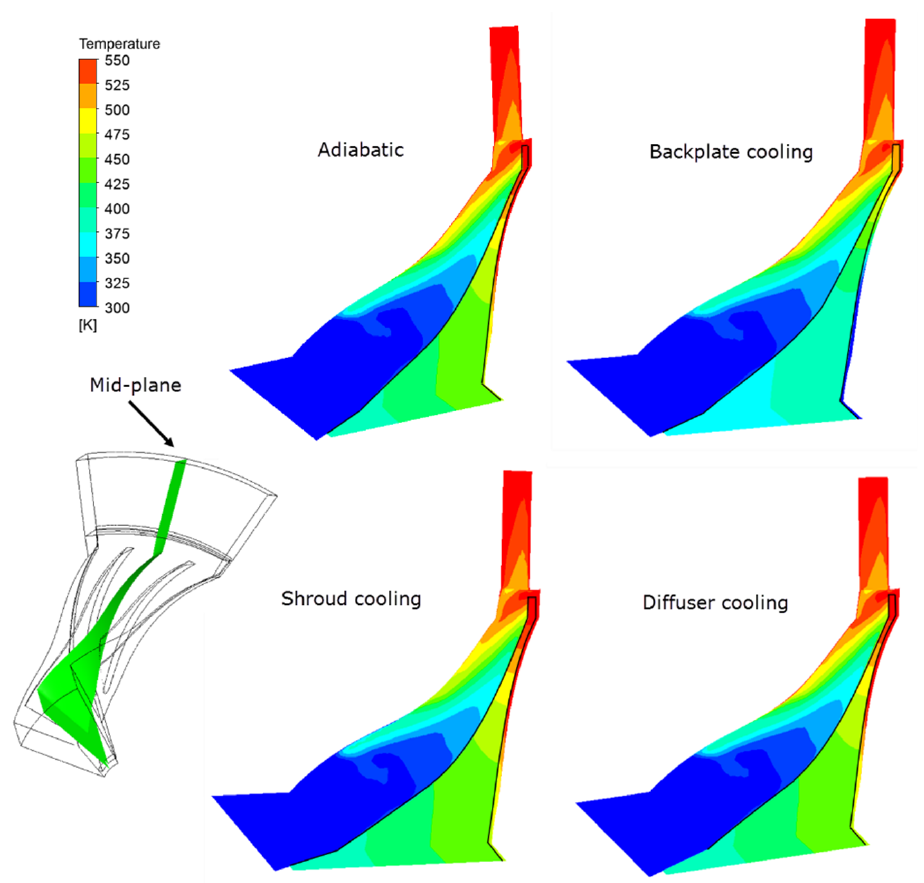
Figure 7. Enthalpy-entropy diagram for the compression process with different thermal Figure 9 . Temperature contours inside the compressor with cooling on different walls.